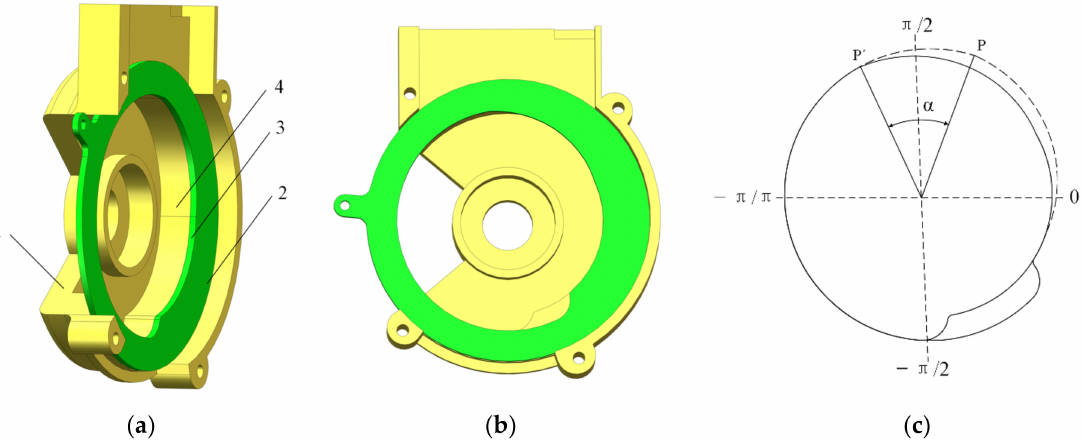
Figure 5. The structure of double tracks. ( a ) Side view; ( b ) front view of rotation α ; ( c ) schematic diagram of rotation α . 1. Shell, 2. adjusting mechanism, 3. inner track, and 4. fixed